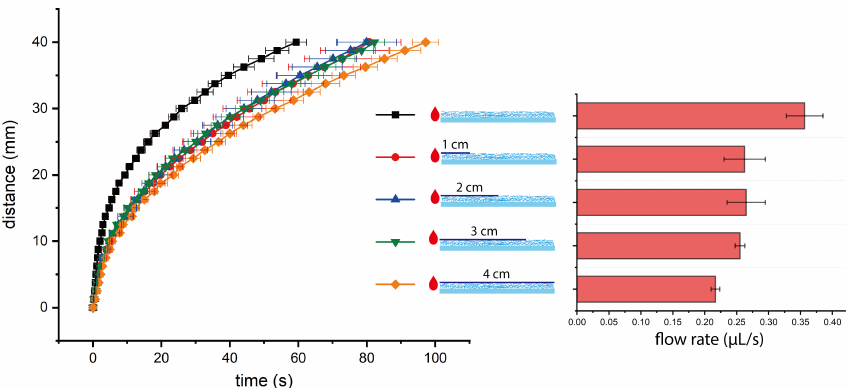
Figure 4. The time-distance plot of DI water flow on nitrocellulose test strips with tapes of different length ( left ), and the average flow rates of different groups ( right ). The tape started from the borderline between loading pad and fluidic channel.